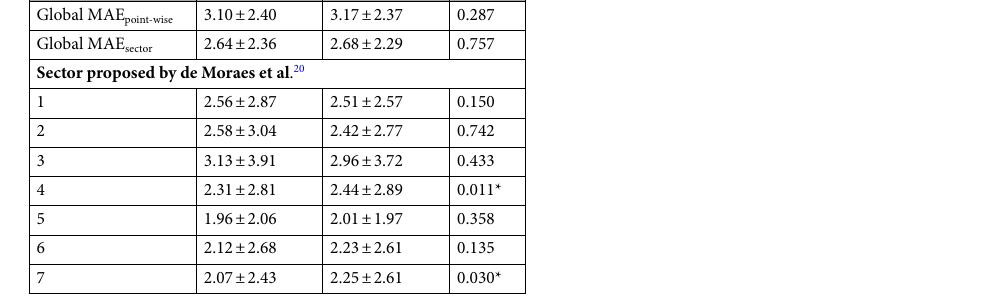
Table 3. Global and the sectoral mean absolute error of 10-2 visual field prediction according to input images using Inception-Resnet-V2. Values are presented as mean ± standard deviation. Significance is marked in * ( P value < 0.05). MAE mean absolute error, RNFLT retinal nerve fiber layer